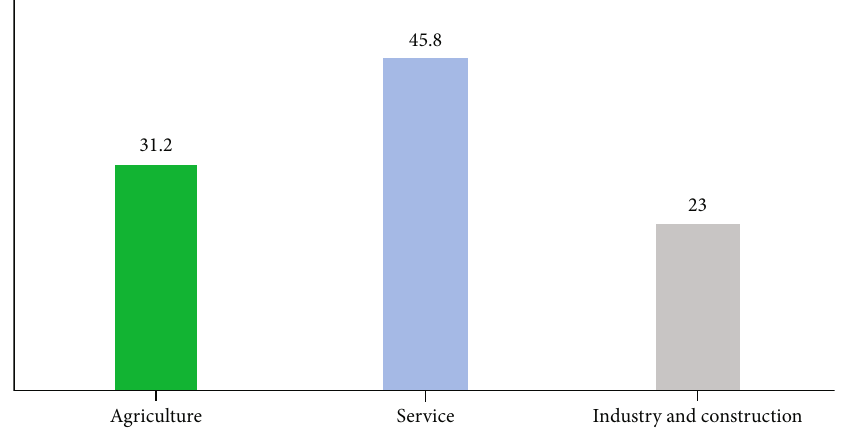
Figure 1: Employment structure by sector of economic activity